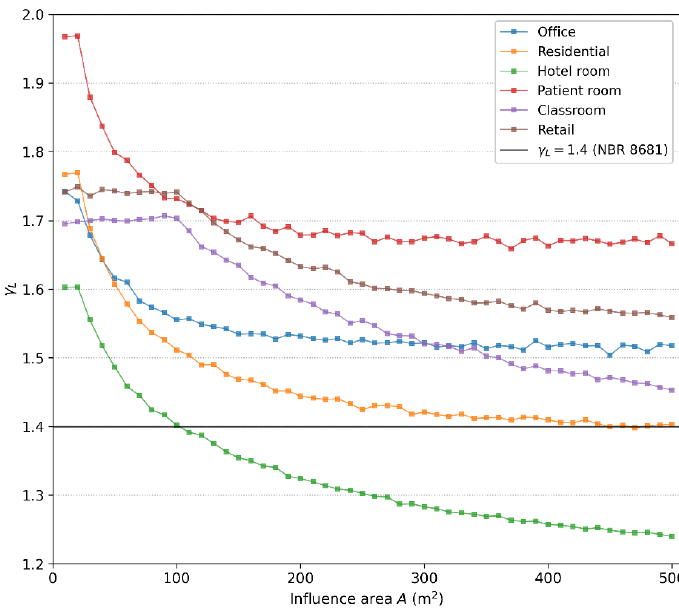
Figure 11. Partial safety factor